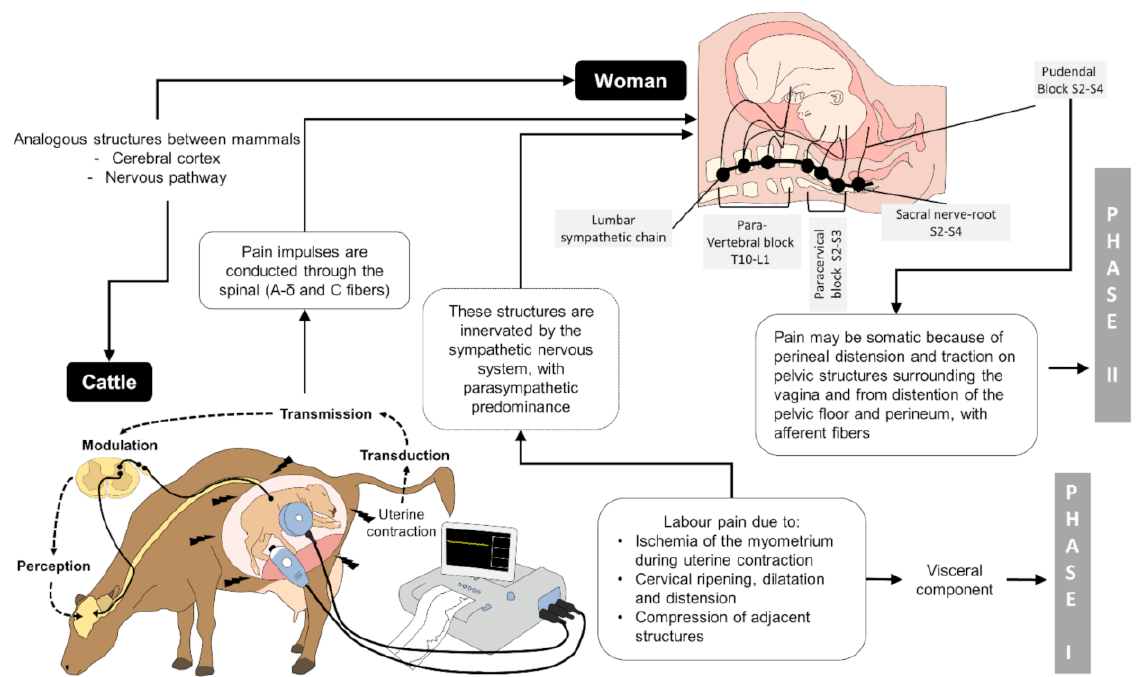
Figure 1. Pathway of pain in labour. In the first stage, there are slight but constant uterine contractions; as the strength of the contractions increases, concomitantly with the distension, effort, and tear of the lower uterine segment and the cervix, it becomes strongest and induces visceral pain with afferent information travelling within the hypogastric and pelvic nerves [15]. In the second labour stage, the expulsion phase is described as the most painful stage due to cervix distension and pressure on the pelvis and perineum, with pudendal nerve innervation. The nociceptive stimuli are processed and transmitted at the dorsal horn of the spinal cord, via the spinothalamic region to the thalamus, brain stem, and cerebellum, where spatial and temporal analysis take place, and also to the hypothalamic and limbic systems [5]. The third stage of labour, the delivery, consists of the expulsion of the placenta and is not painful